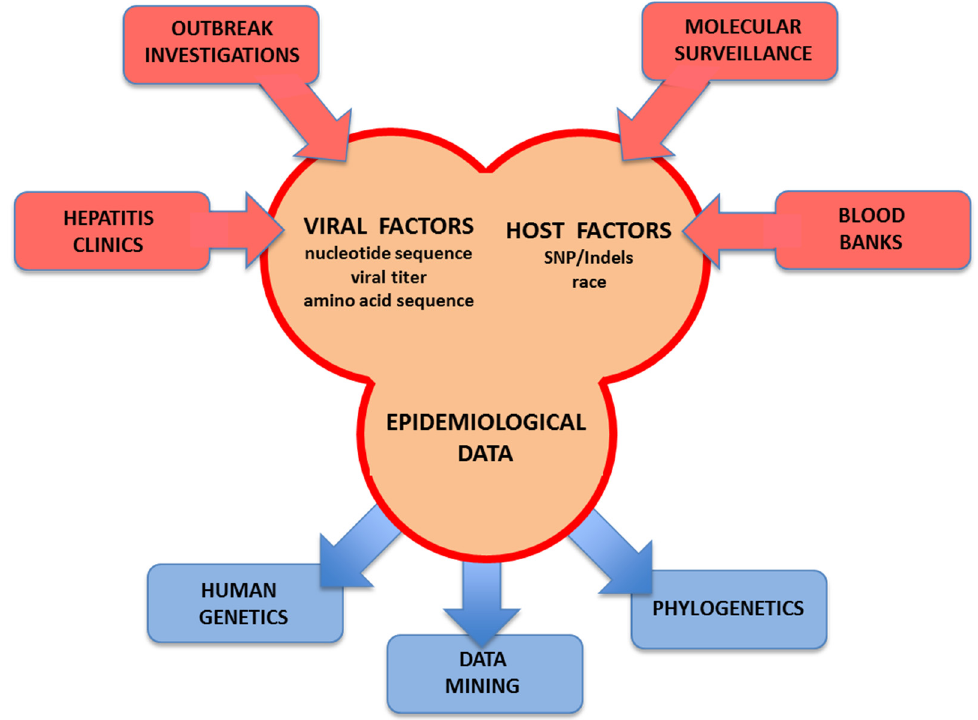
Figure 6. Advanced HCV molecular surveillance. The main components required for advanced molecular surveillance of HCV are listed. Global databases containing comprehensive information concerning transmission events are used as a source of information to draw conclusions about viral spread. Advanced molecular tools and data mining analyses are required to accurately identify the nuances driving the transmission of